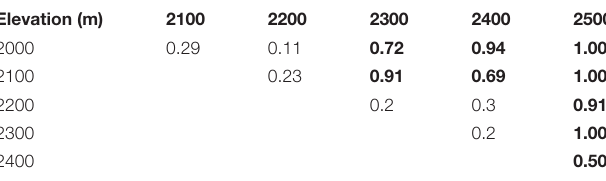
2400 0.50 An R-value near + 1 means that there is dissimilarity between the groups, while an. R-value near 0 indicates no significant dissimilarity between the groups. Values in. Bold indicate significant dissimilarity (P <